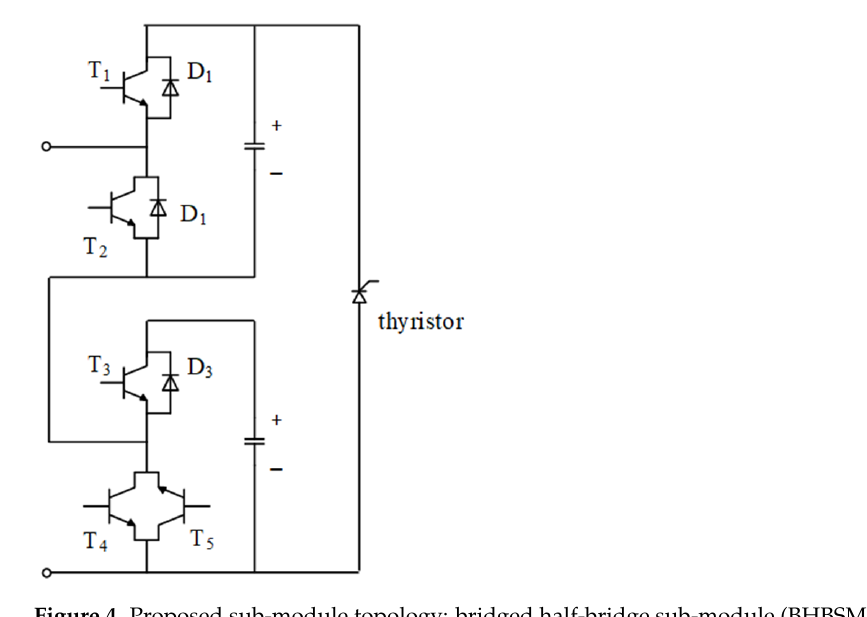
Figure 4. Proposed sub-module topology: bridged half-bridge sub-module (BHBSM).